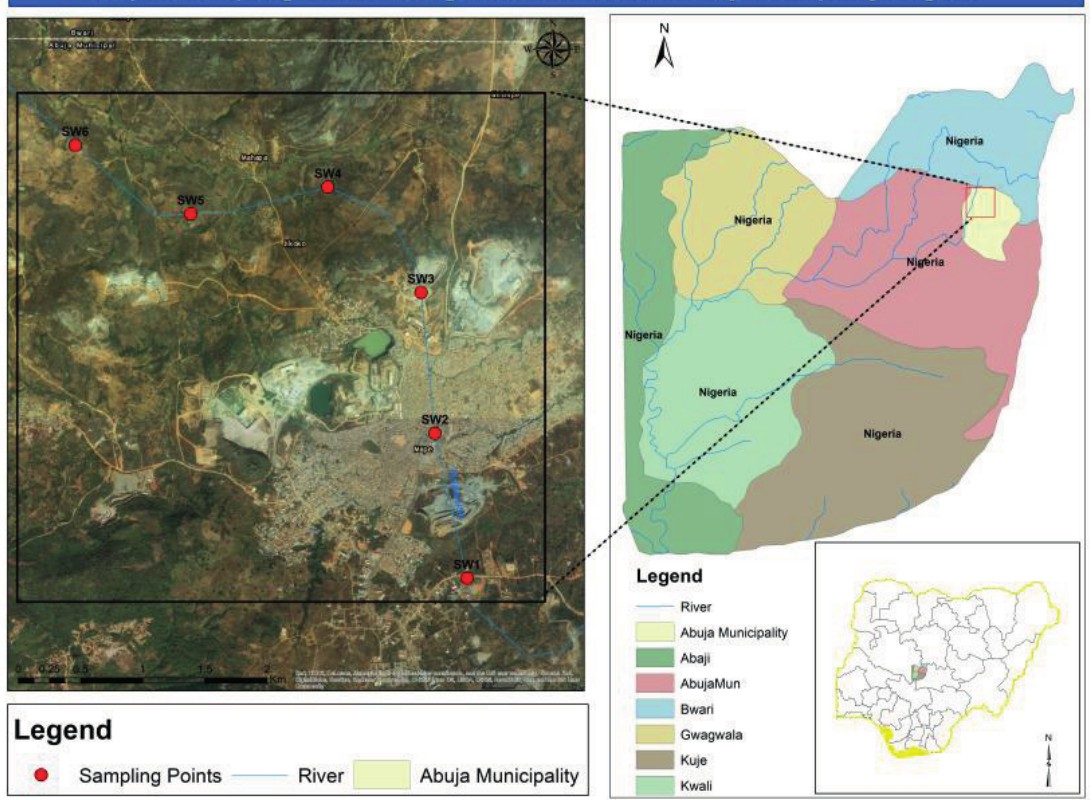
Figure 1: Map showing the sampling points along Ndawuse River in Abuja, the Federal Capital Territory (FCT),